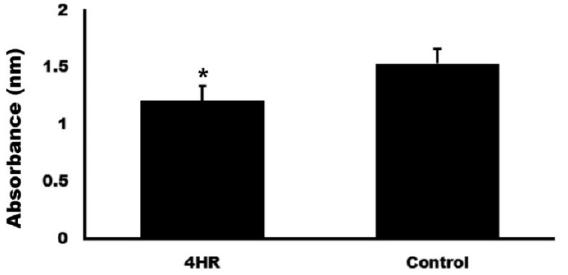
Figure 2. Blood coagulation test results. The absorbance of the 4-HR was significantly different from that of the control ( p = 0.034).